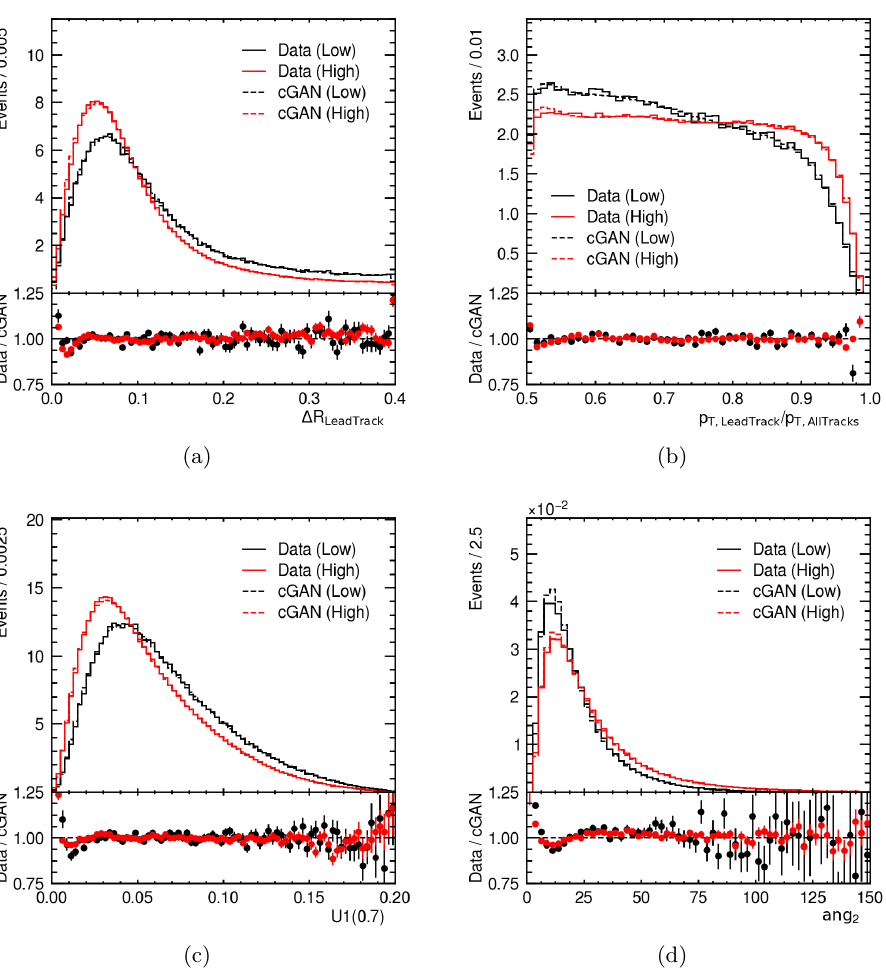
Figure 13 . Jet substructure variables in mock data and modelled by the cGAN, which are used as inputs to the classification MLP, shown for the low and high m bars on the markers in the lower panels represent the statistical uncertainty on the mock